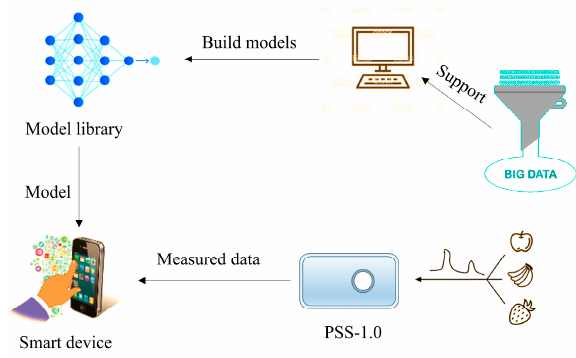
Figure 7. Spectral analysis system.